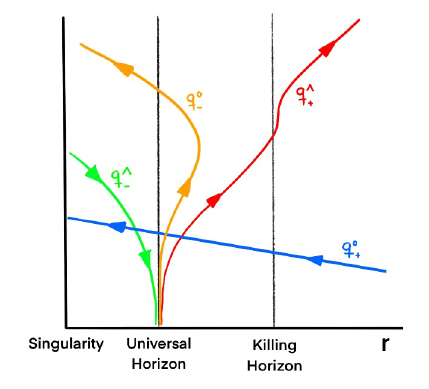
Figure 3. Artistic representation of the behavior of the modes close to the universal horizon. The proper time of every trajectory is shown by the little arrow on top of them. For a concise derivation of this behavior, check the computation in